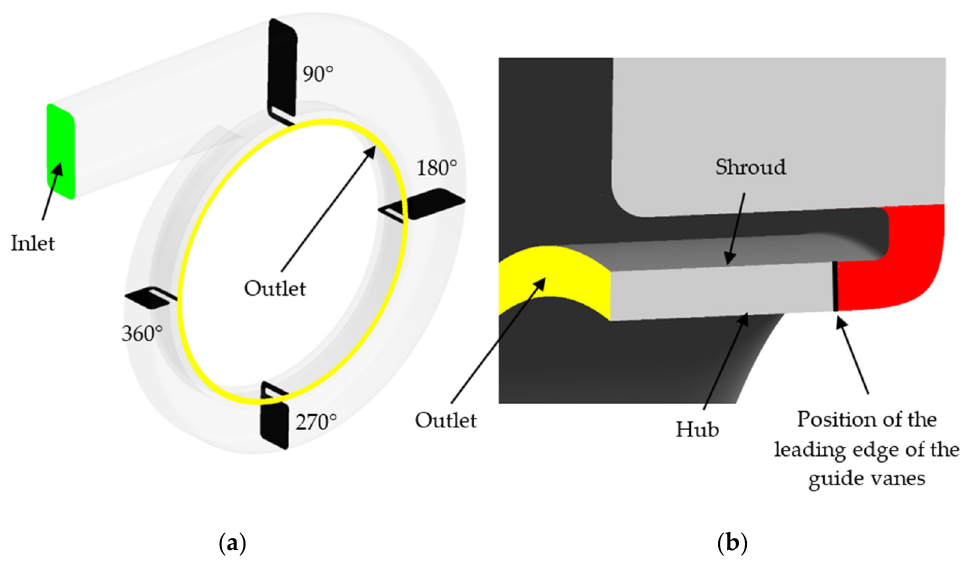
Figure 1. Scroll distributor geometry: ( a ) general view with control sections; ( b ) cross-section of the channel for the 90° section.